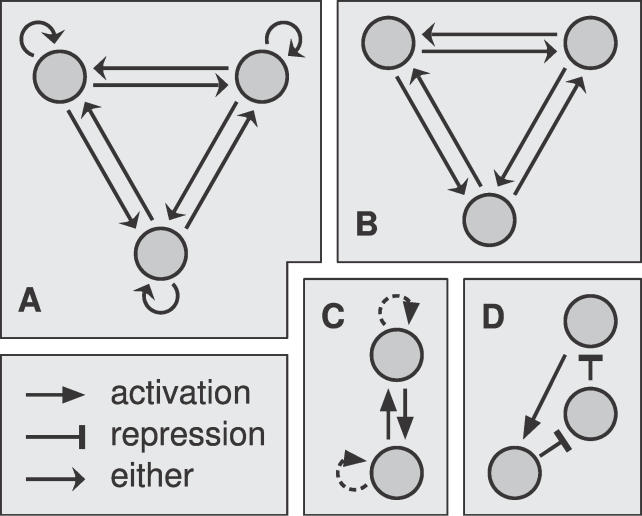
Putative Network Motifs Related to the System of OCT4, SOX2, and NANOGThe motif in (A) captures the regulatory interactions of the system at the gene–gene level. Because (A) was not observed in any of the databases for lower organisms (see text), we searched for the same subgraph without autoregulations (B), followed by its two-gene counterpart with positive regulation (C). Finally, one of the activations was replaced with two repressions in series, yielding (D). A small number of instances of (C) and (D) were found in the databases (see text).